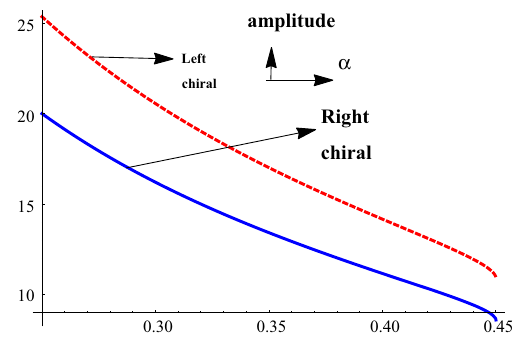
λ L , R Fig. 4 vs. α in F ( R ) theory for M = 1, (cid:9) = − 1 and m 5 = m rad